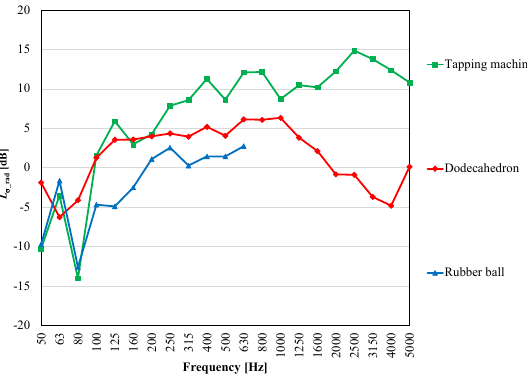
Figure 14. Measurements of radiation index: tapping machine (50–5000 Hz), dodecahedron (50–5000 Hz) and rubber ball (50–630 Hz). Finally, by looking at the average of the nine measurements and at the variability of values for the nine measurements of the radiation indices, for each of the three sources (Figure 15), some considerations can follow.